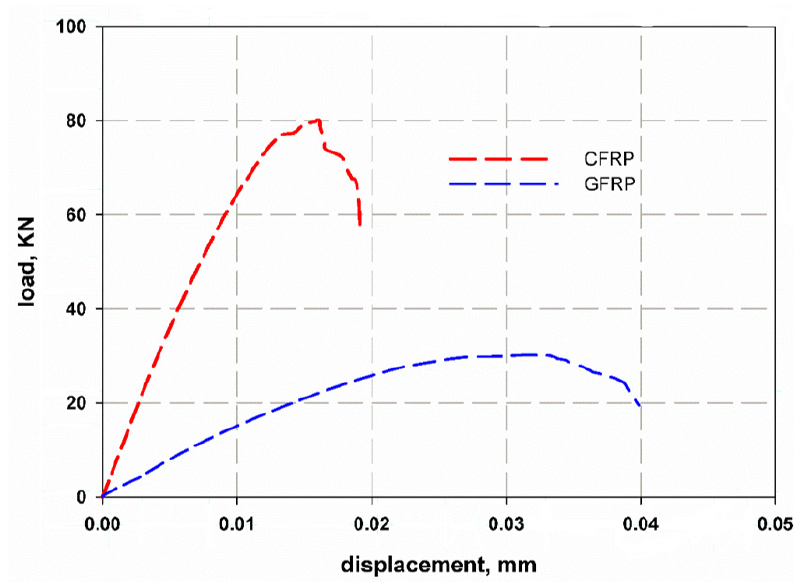
Figure 11. Load versus displacement relationship for center crack notch specimen.